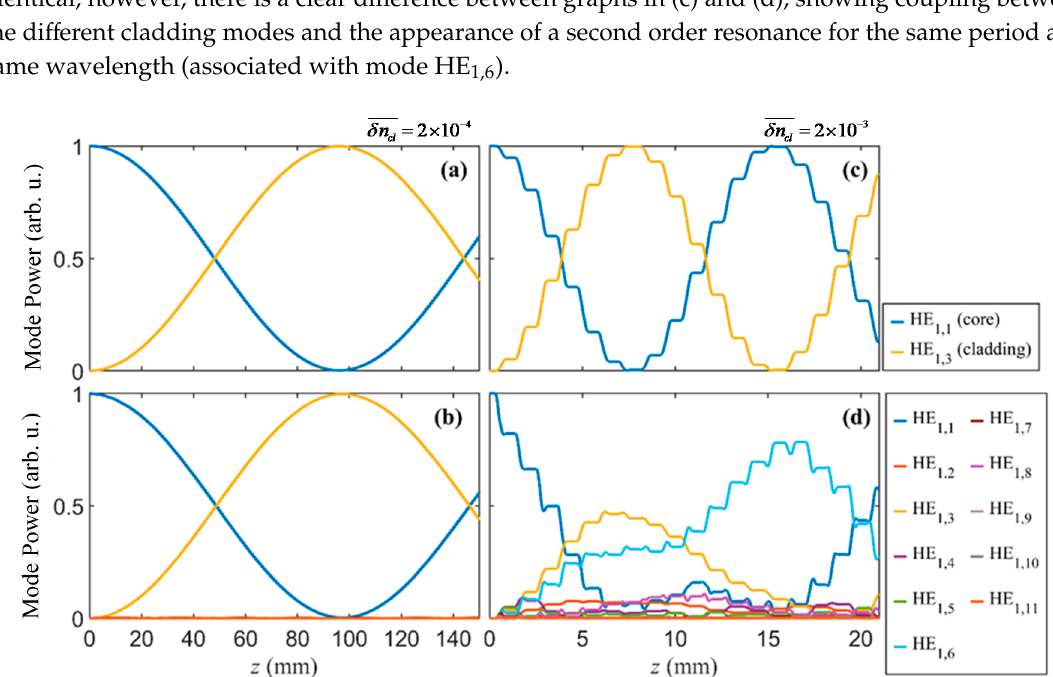
Figure 3. Power evolution in an LPG calculated with one ( a , c ) and ten ( b , d ) cladding modes simultaneously. A δ n cl = 2 × 10 − 4 with a period of 821 µ m ( a , b ) and a δ n cl = 2 × 10 − 3 with a period of 1117 µ m ( c , d ) and a wavelength of 1550 nm were considered.